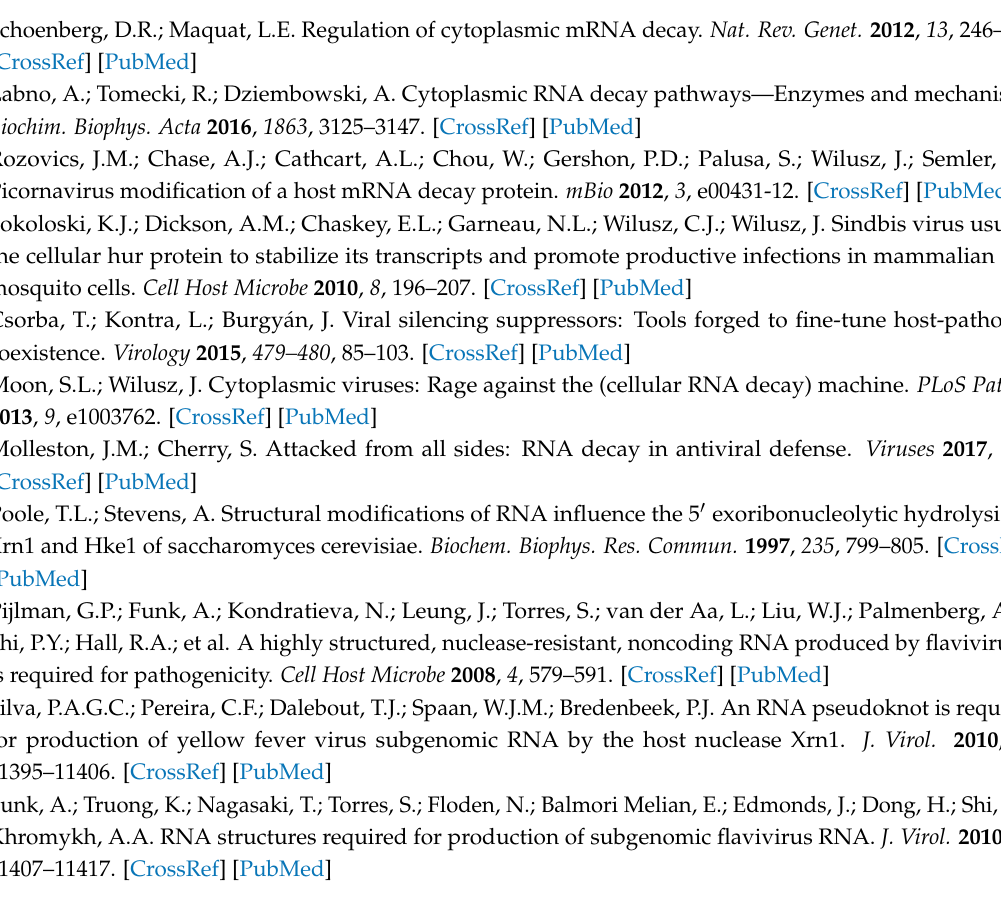
Figure S1: Expression of BNYVV RNA3 species in Saccharomyces cerevisiae FY4 and mutated